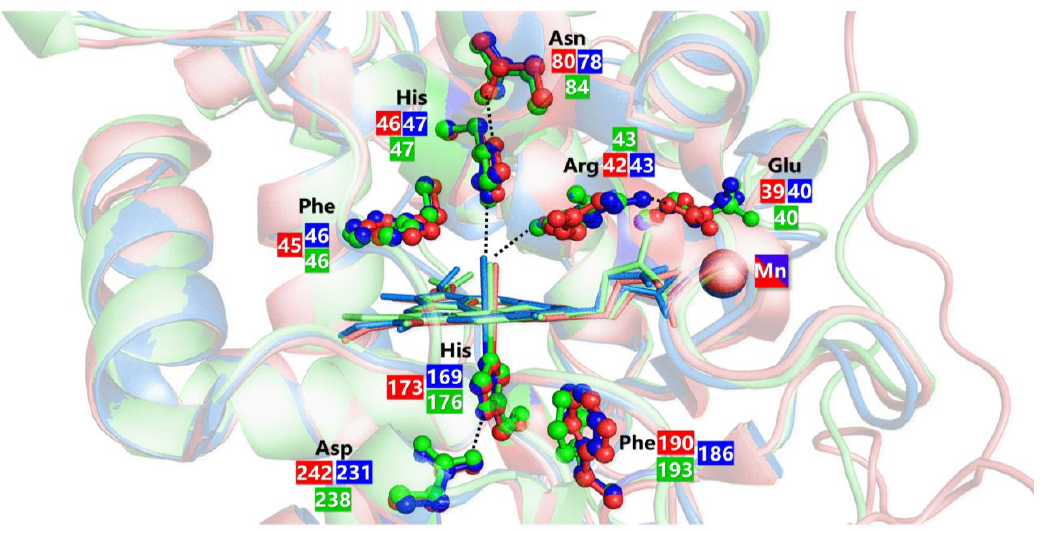
Figure 10. Representation of the conserved residues in the heme pocket of all ligninolytic peroxidases. MnP is represented in red (PDB: 1YYD), VP is represented in blue (PDB: 2BOQ), and LiP is represented in green (PDB: 1B82).